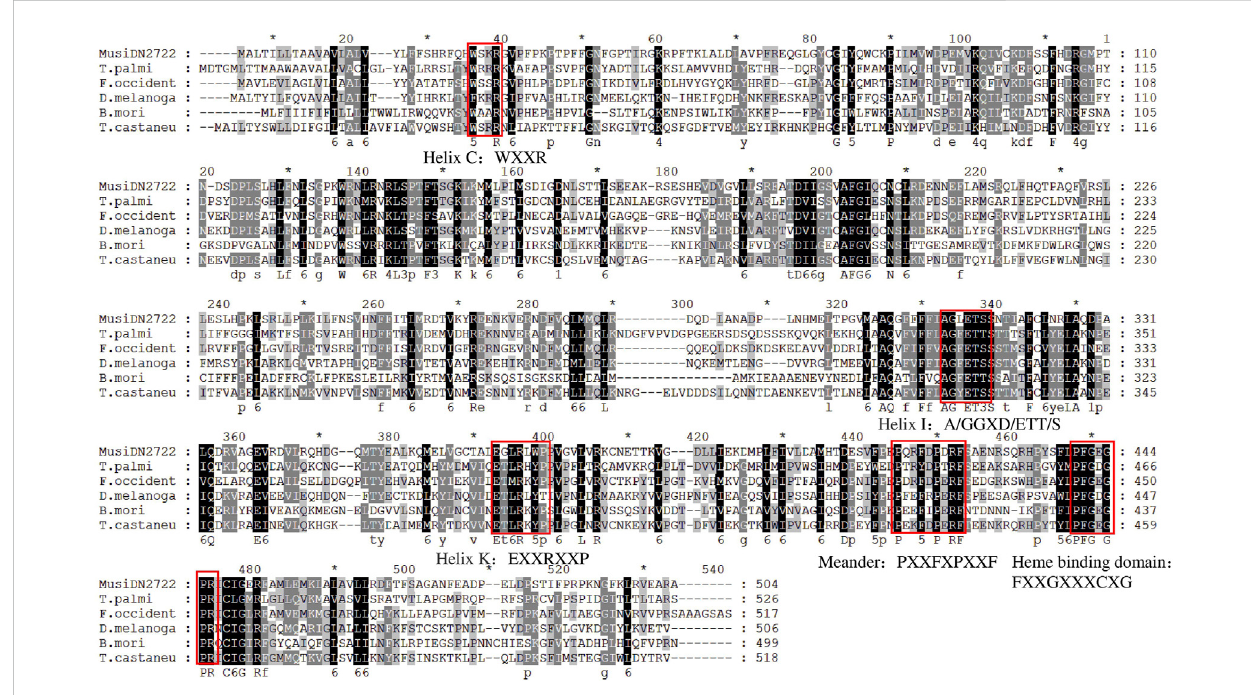
FIGURE 4 Multiple sequence alignment of M. usitatus cytochrome P450s. Included species and corresponding Genbank accession numbers: T. palmi , Thrips palmi (XP_034255739.1 CYP6a2); F. occident , Frankliniella occidentalis (KAE8752265.1 CYP6); D. melanoga , Drosophila melanogaster (AAF58185.2 CYP6a8); B. mori , Bombyx mori (XP_037874445.1